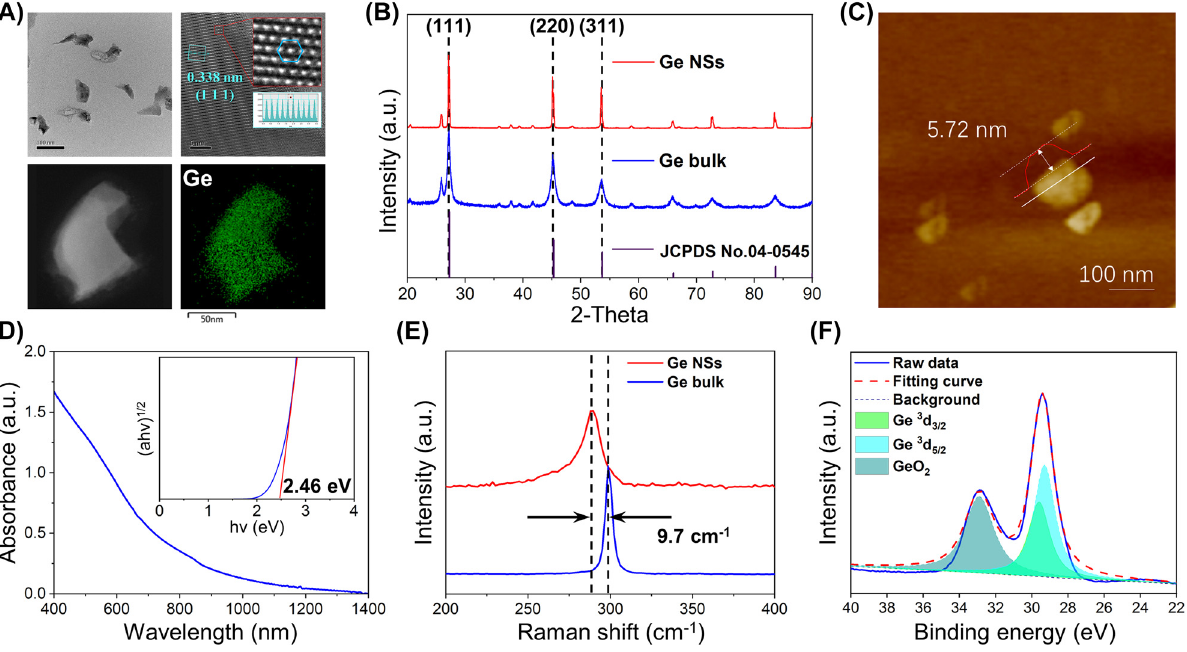
Figure 2: Characterization of the germanium nanosheets. (A) TEM image with shape, HR-TEM image with lattice and element mapping image of germanium NSs; (B) XRD spectrum of germanium NSs; (C) AFM image with thickness of germanium NSs; (D) UV–vis absorption spectrum of germanium NSs with optical bandgap; (E) Raman characteristic peak shift between germanium power and germanium NSs; (F) XPS spectrum of germanium